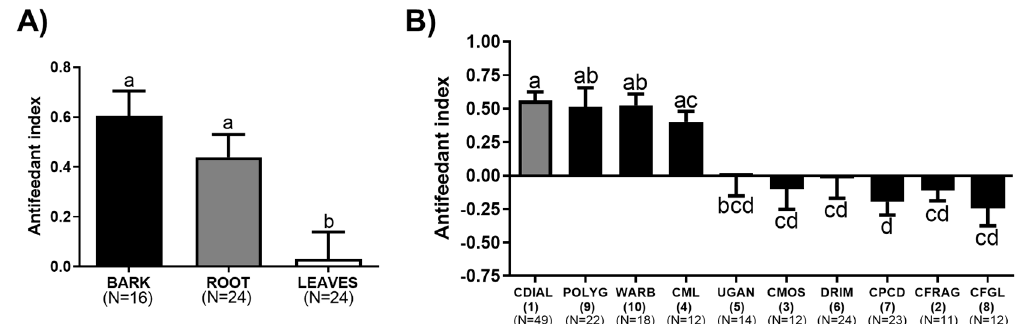
Figure 5. The antifeedant activity of plant extracts ( A ) and isolated drimane sesquiterpenes ( B ) in choice capillary feeding (CAFE) assays with adult female Ae. aegypti (LVP strain) mosquitoes. At the time of feeding, each group of five mosquitoes was offered two glass capillaries filled with 10% sucrose and 0.01% trypan blue. The control capillary included 1% acetone (the solvent), and the treatment capillary included 1% acetone and an extract (50 μ g/mL) or a drimane sesquiterpene (1 mM). The difference in volume consumed between the capillaries was used to calculate the antifeedant activity. See Figures S1 and S2 for consumption volumes. Values are means ± SEM; N = number of independent replicates of five mosquitoes each. Lower-case letters indicate statistical categorization of the means as determined by a one-way ANOVA and Tukey’s multiple comparisons test ( p <0.05).